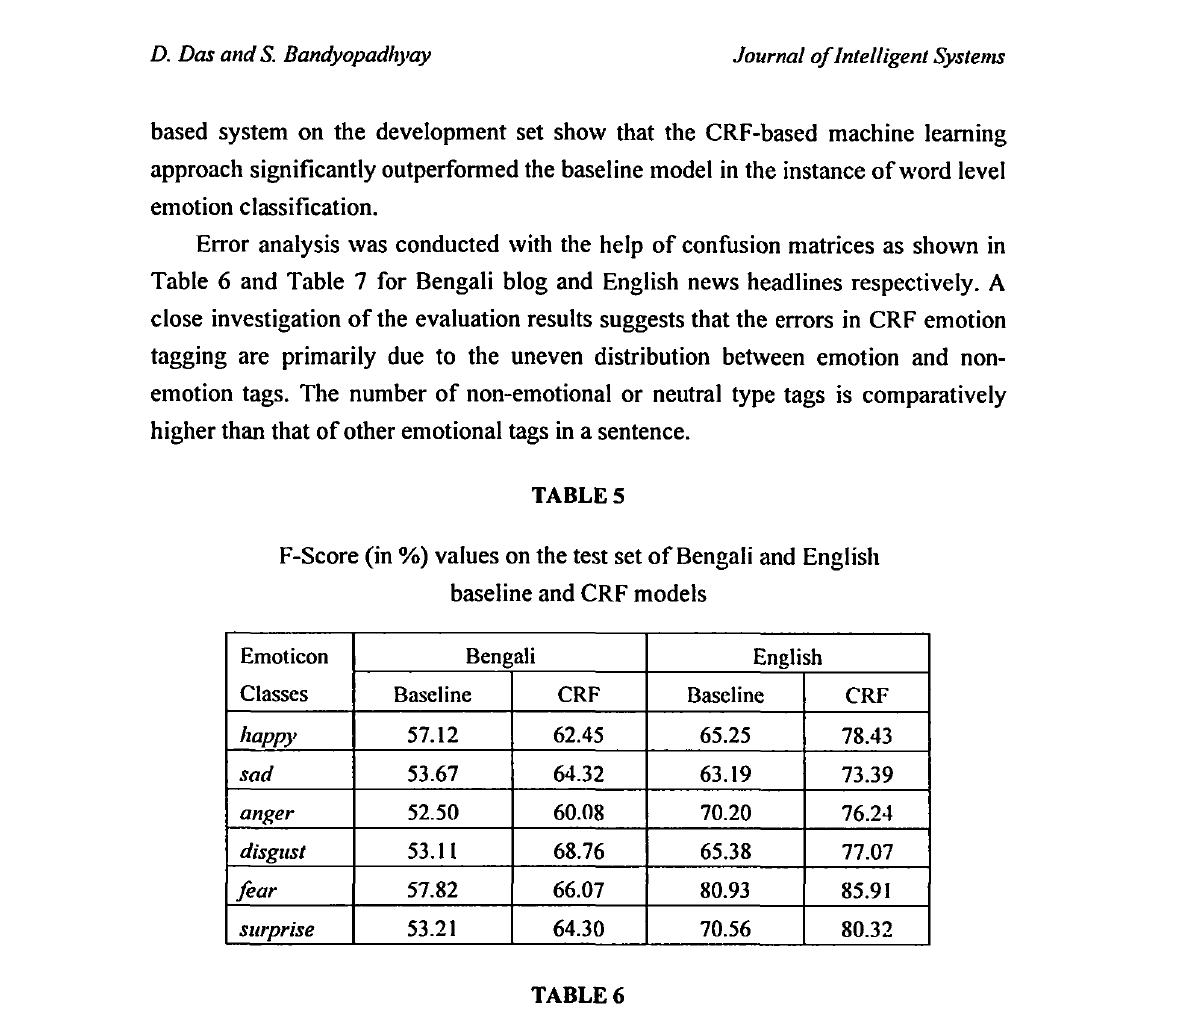
Confusion matrix for the development set of Bengali